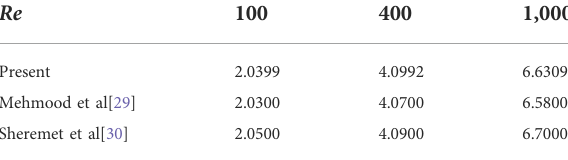
TABLE 2 Code validation for con fi guration without an obstacle.